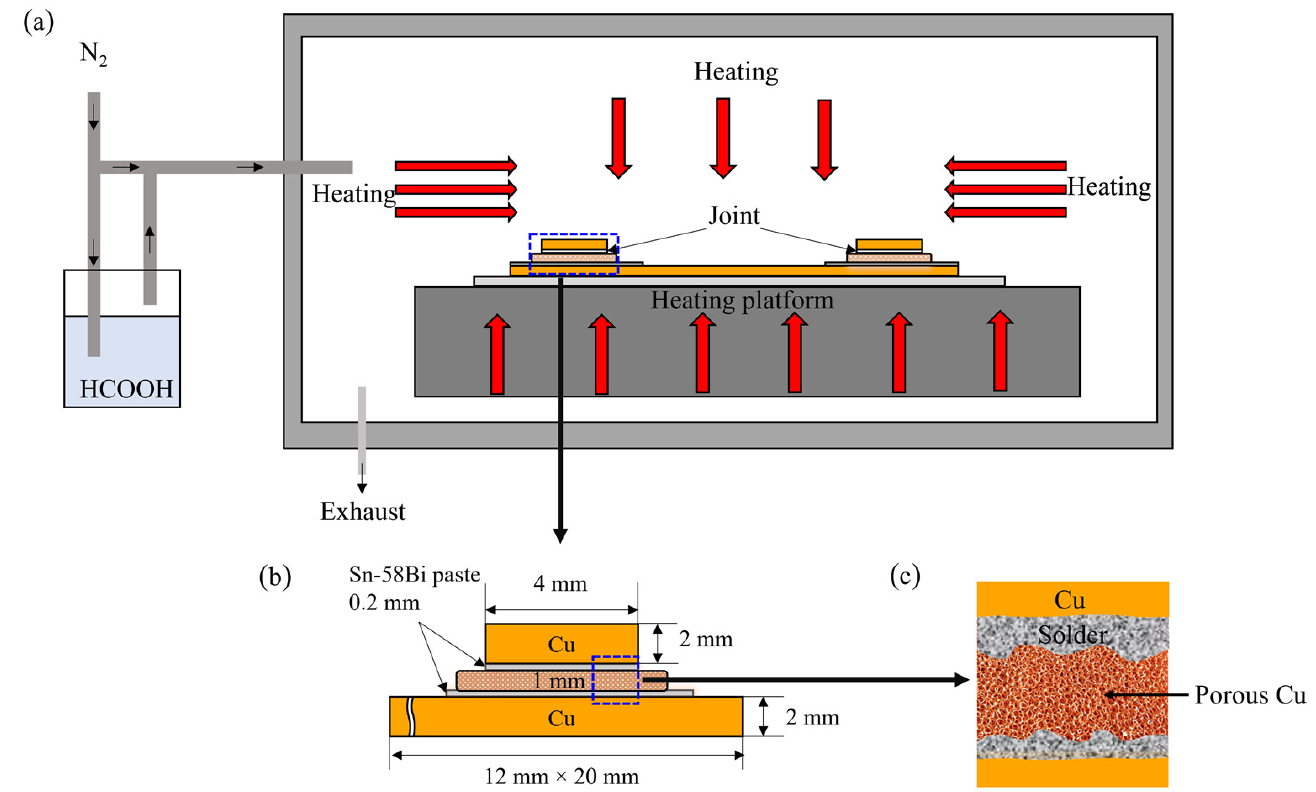
Figure 1. Schematic graph of the method in this study: ( a ) bonding process under FA atmosphere; ( b ) Sn58Bi solder/micro-size porous Cu foil/Sn58Bi solder sandwich structure; ( c ) partial enlarged view of the sandwich structure.